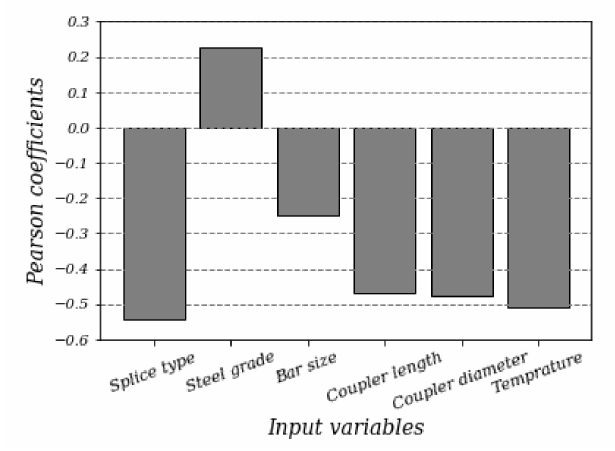
Figure 1. Pearson coefficients of the input variables.